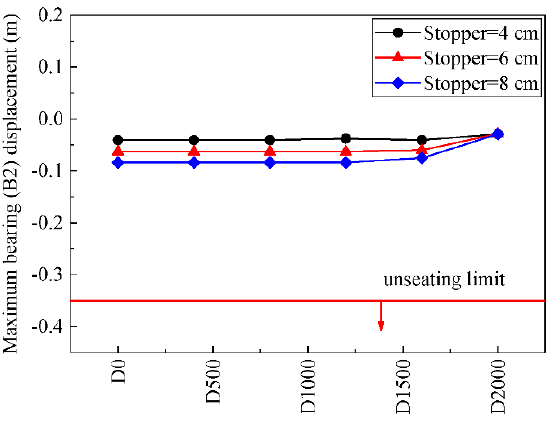
Figure 10. Possibility of deck unseating damage.